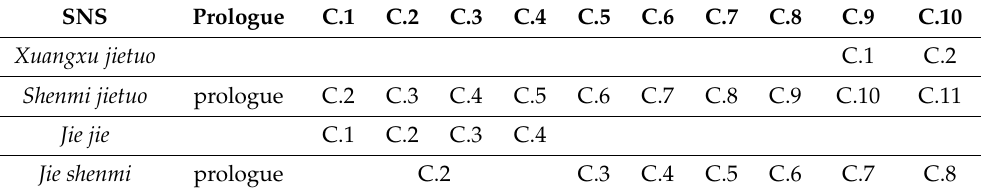
Table 1. The chapters of four Chinese translations of the